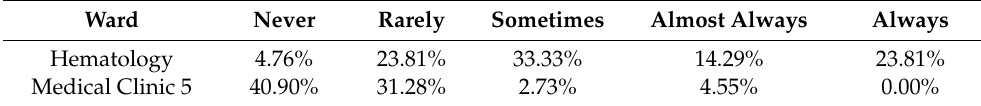
Table 4. Most significant response differences in relation to question 8d.